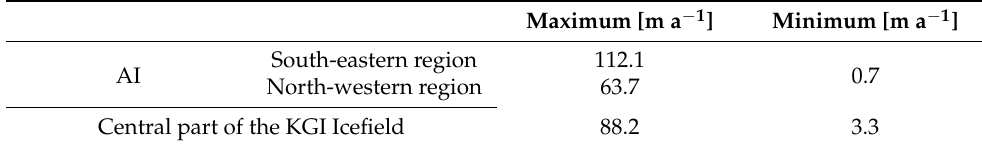
Table 2. Surface velocities measured on the KGI by dGPS